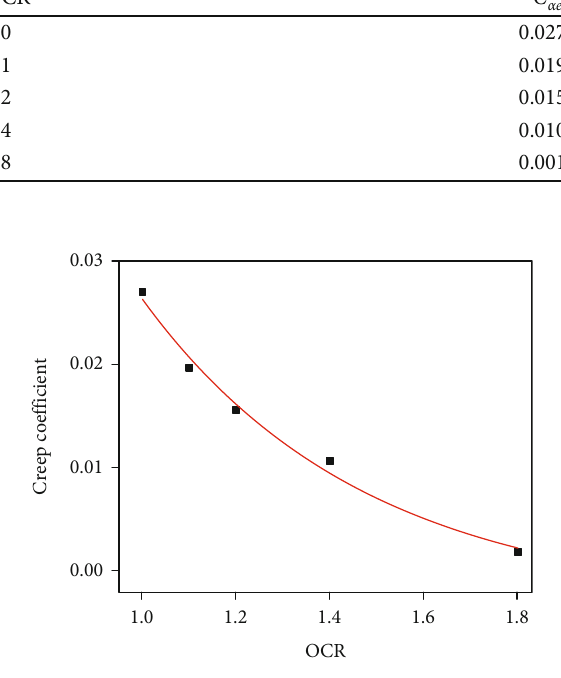
Figure 10: The relationship between the creep coe ffi cient and OCR.